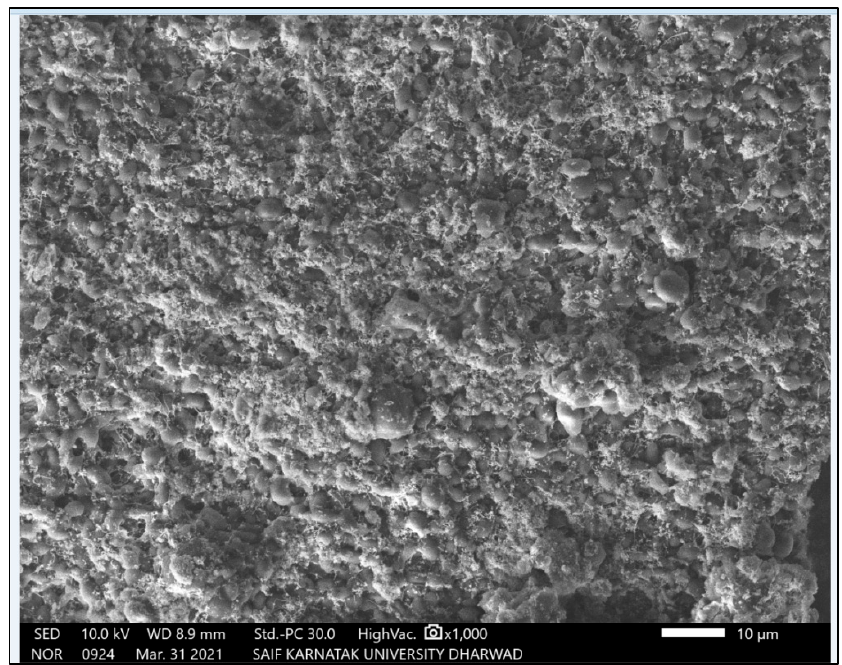
Figure 3. SEM micrograph of green synthesized AgNPs using M. indica aqueous leaf extract.